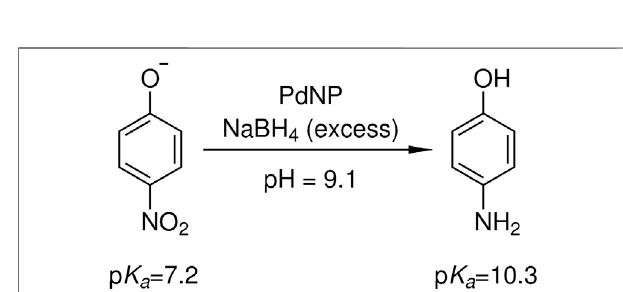
FIGURE 4 | Catalytic reduction of 4-nitrophenolate to 4-aminophenol with an excess of sodium borohydride in the presence of palladium nanoparticle containing core-shell microgels. Due to the hydrolysis of sodium borohydride, an initial pH value of 9.1 is present and the product 4- aminophenol with a p K a of 10.3 remains in its protonated state (Haynes,